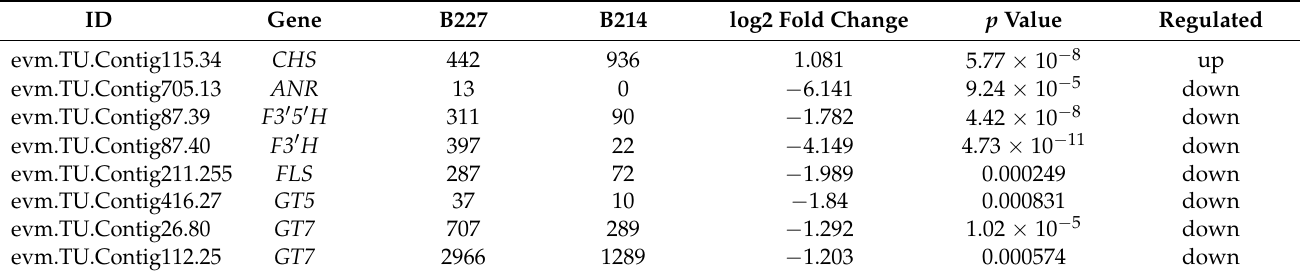
Table 3. DEGs involved in the flavonoid pathway in the mature pericarp of B227 and